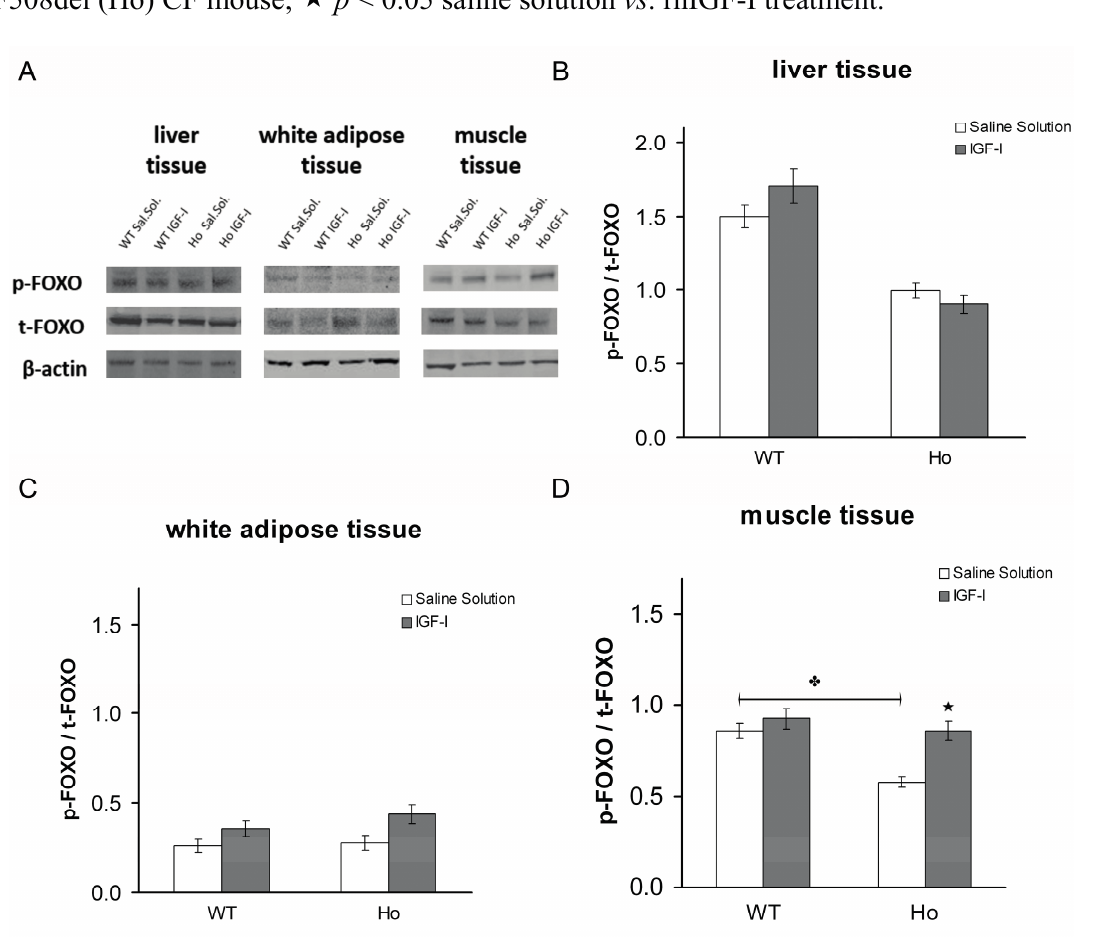
Figure 10. FOXO1 content in mouse tissues ( A ). Phosphorylated [S256]/total FOXO1 (p-FOXO1/t-FOXO1) ratio in liver ( B ); white adipose tissue ( C ); and skeletal muscle ( D ), in 129/FVB CF-affected mice (Ho) and in their wild-type littermates (WT) in baseline conditions and after treatment with rhIGF-I (4 µg/hg/day for 5 days). The p-FOXO1/t-FOXO1 ratio was similar in liver and white adipose tissue but was significantly different between normal and CF mice in skeletal muscle. IGF-I treatment increased the p-FOXO1/t-FOXO1 ratio in CF skeletal muscle to a value similar to that in WT. A non-significant increase was observed in white adipose tissue also. p < 0.05 wild-type (WT) mouse vs .